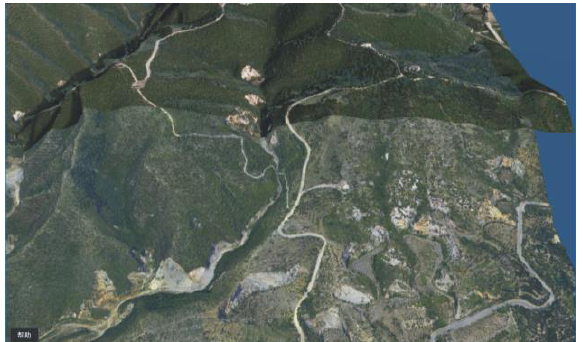
Figure 6. Integration of the both 3D scene on Cesium platform (the upper part is 3D scene model of UC and the lower part is that of RC-30).